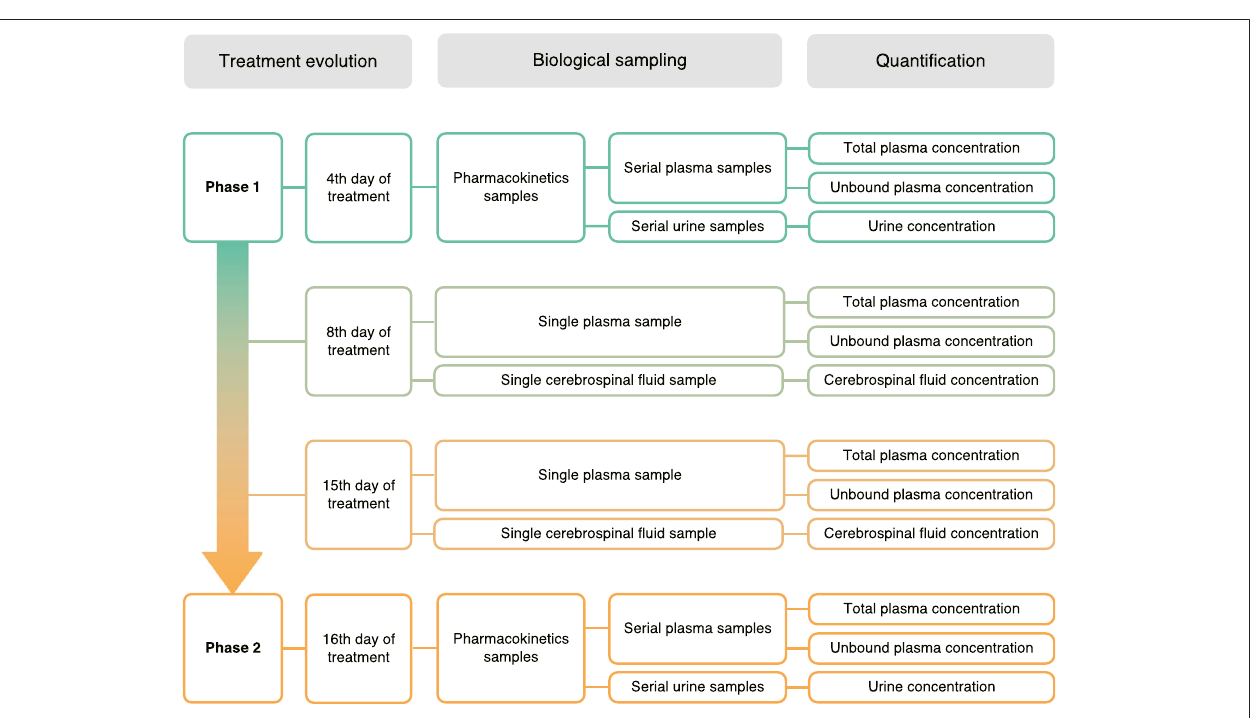
curve. AmB was assessed by non-compartmental analysis (NCA) with the linear trapezoidal linear interpolation method. Unbound fractions (F u ) were analyzed on the last fi ve samples from the pharmacokinetics curve of each phase as well as on the plasma samples obtained simultaneously as CSF samples.